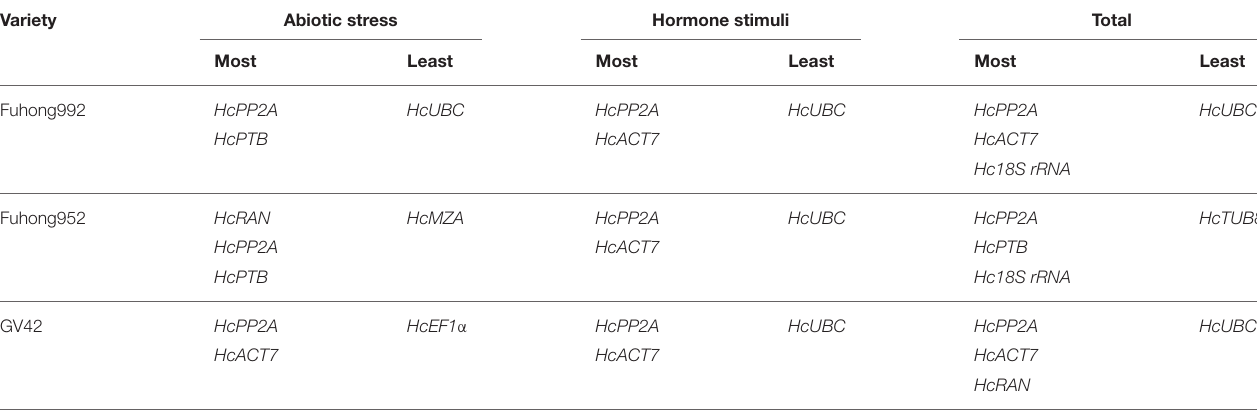
TABLE 3 | Suitable reference genes ranked by geNorm and comprehensive analysis in different kenaf varieties.